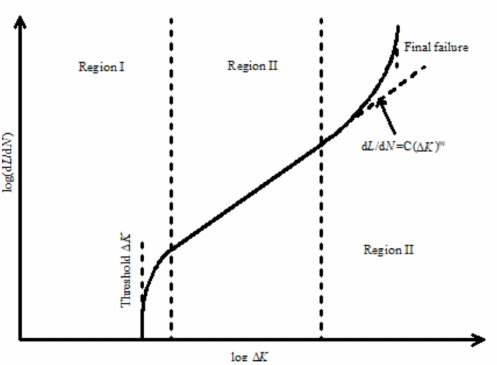
Figure 2. Typical relationship between log (d L /d N ) and log ( ∆ K